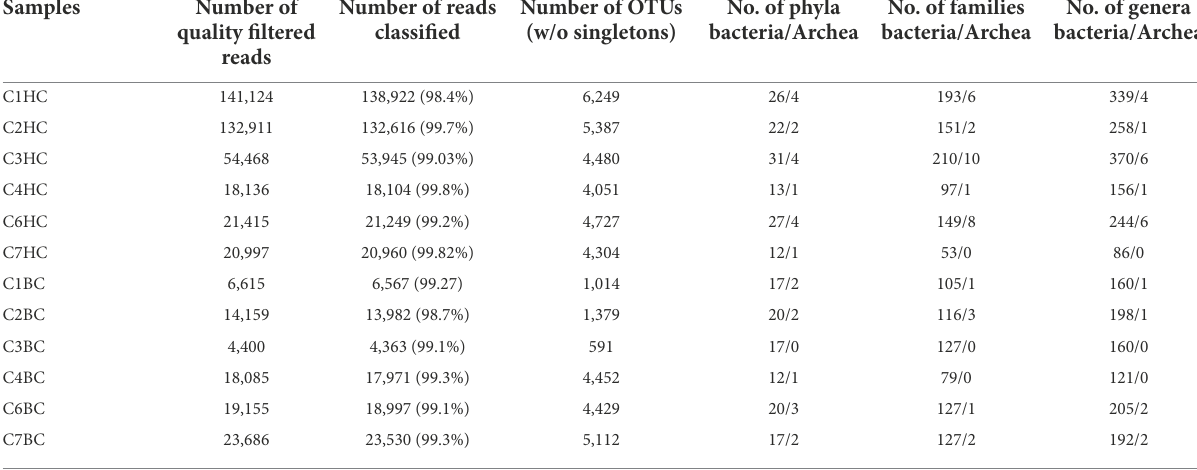
TABLE 1 Sequencing information of samples in H 2 + CO 2 (designated as C1–C7 HC) and HCO 3 − (are designated as C1–C7 BC) enrichment samples. Samples